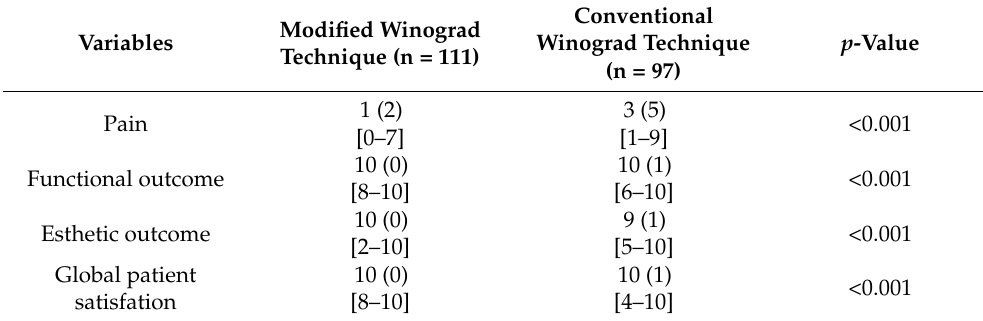
Table 2. Outcomes of overall patient satisfaction with modified and conventional Winograd tech- niques